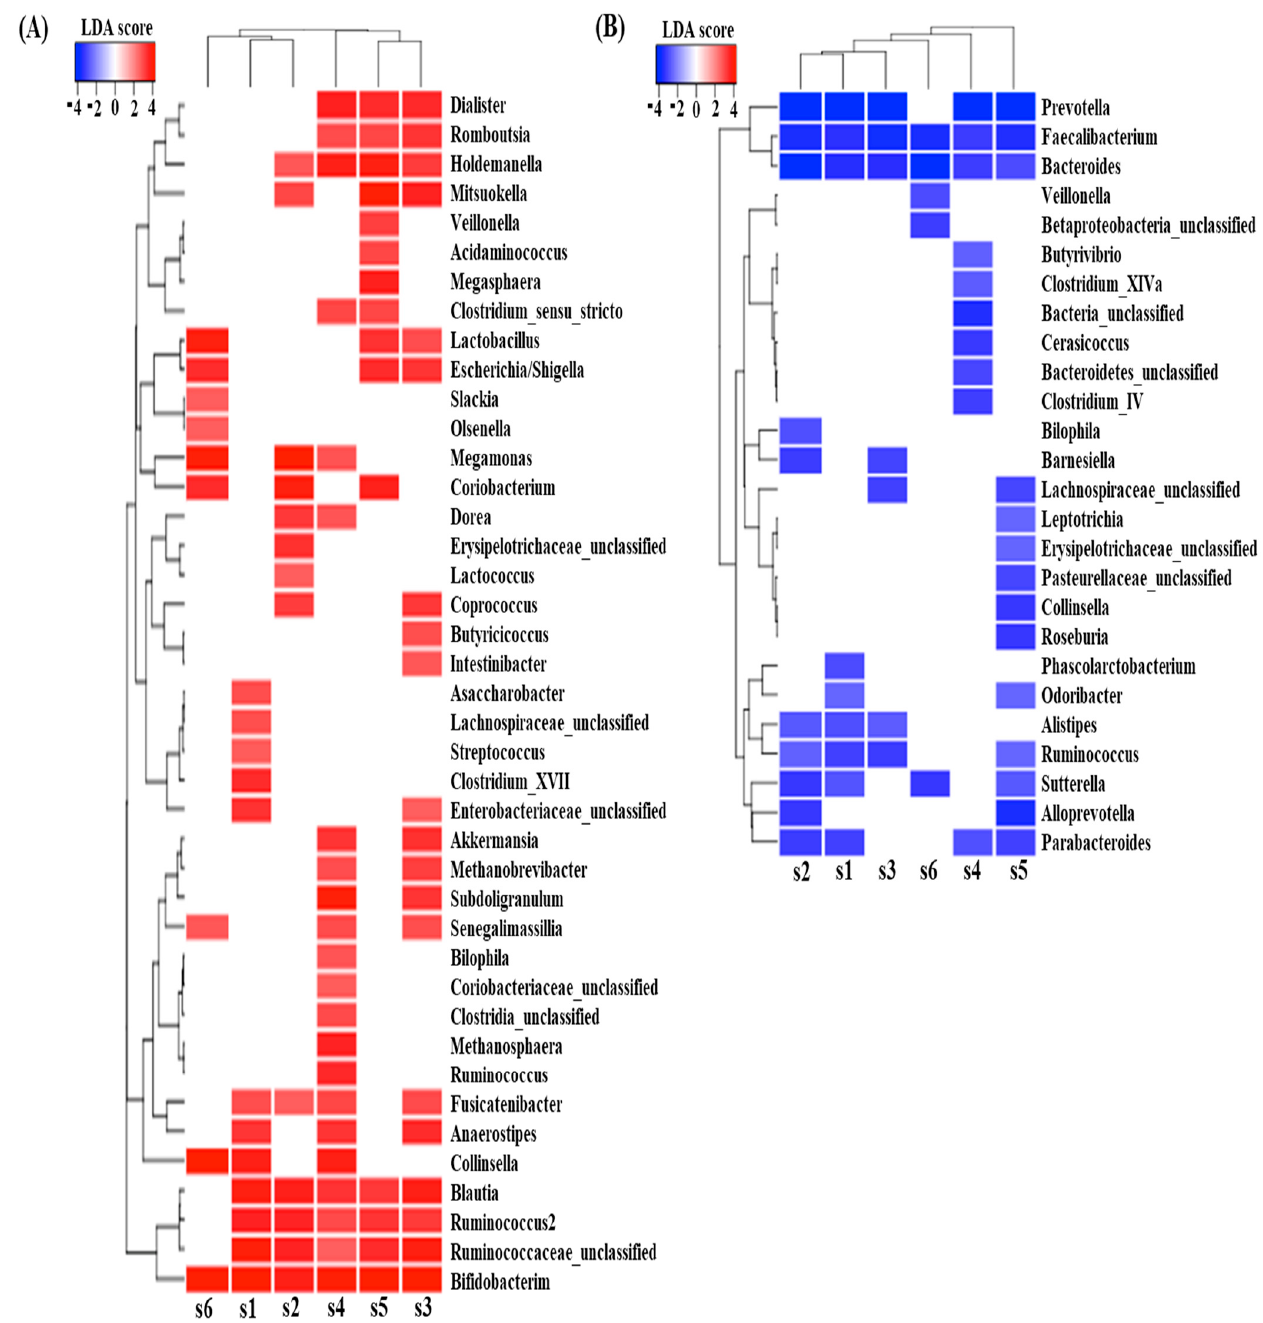
Figure 4. LefSe analysis predicted significantly increased genera ( A ) and decreased genera ( B ), following 90 min of fecal fermentation with digested